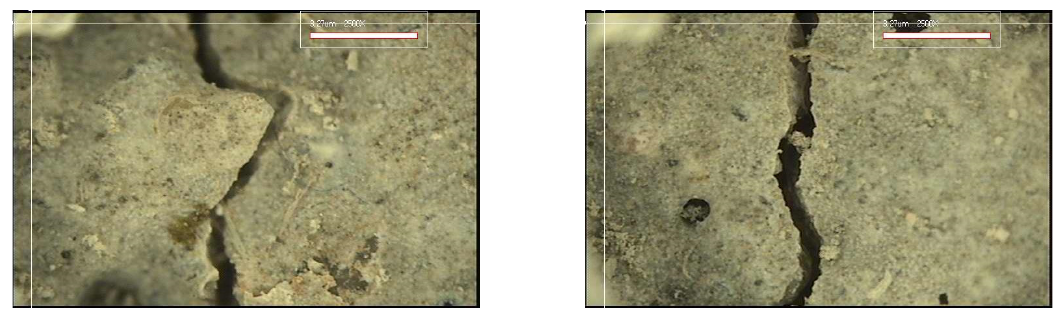
Figure 17. Surface crack monitoring of MCs 0%.